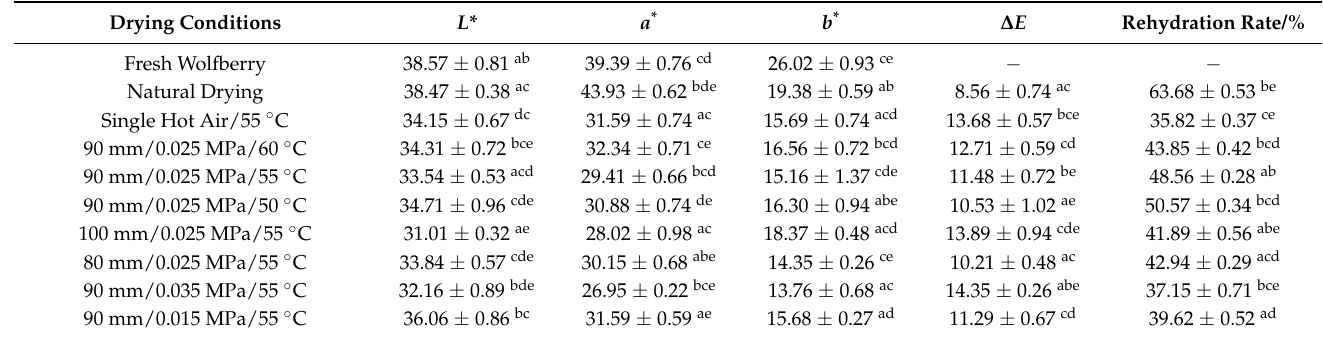
Table 1. Color difference and rehydration rate of L. barbarum under different drying